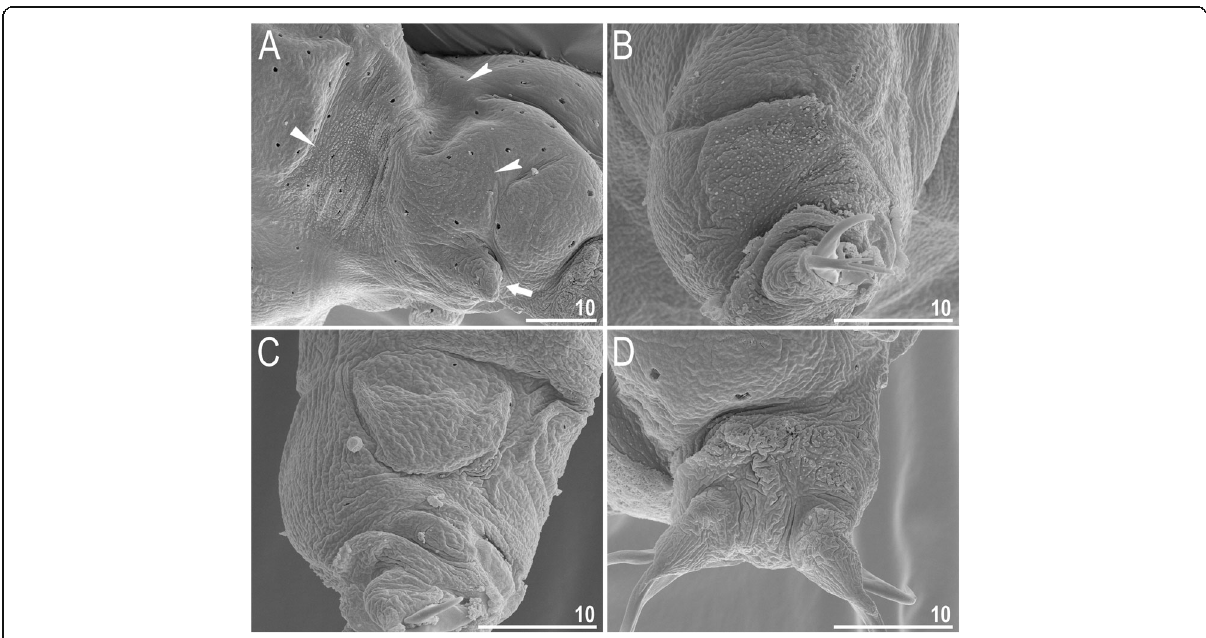
Fig. 5 Macrobiotus pallarii Maucci, 1954 from the topotypic population (IT.337) – body and leg cuticle morphology seen with SEM: a – band of caudal granulation on the last body segment; b – granulation on the external surface of leg II; c – internal surface of leg II with evident pulvinus; d – granulation on dorsal surface of leg IV. Filled flat arrowheads indicate dense patches of granulation in the caudal band, filled indented arrowheads indicate sparse granulation in the caudal band, arrow indicates lateral gibbosity – a male secondary sexual character. Scale bar in μ m